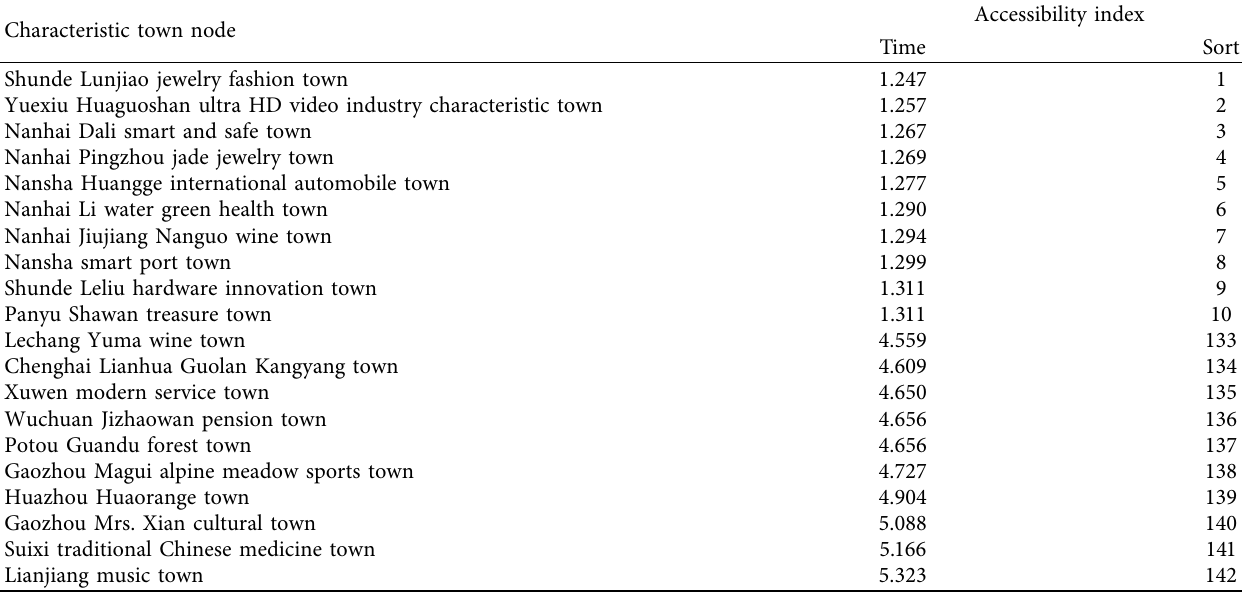
Table 1: Comparison of accessibility of 142 Characteristic Towns in Guangdong